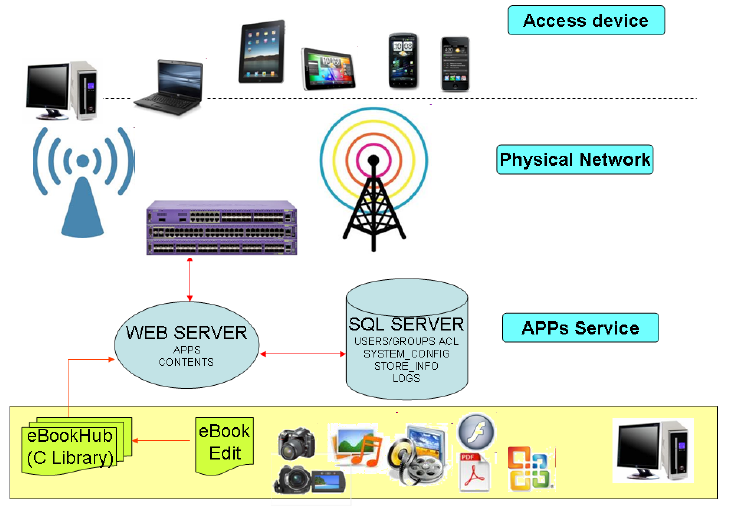
Figure 2. E-book system